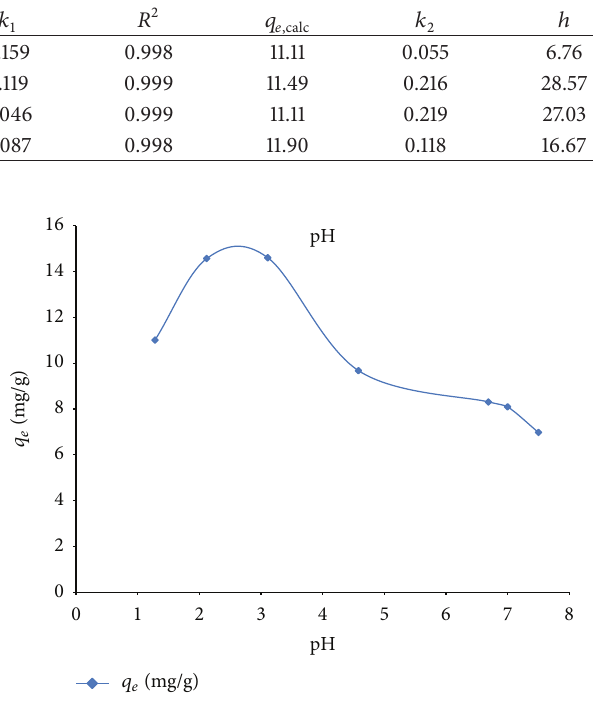
Figure 5: Effects of pH on adsorption of Acid Blue 161 on raw